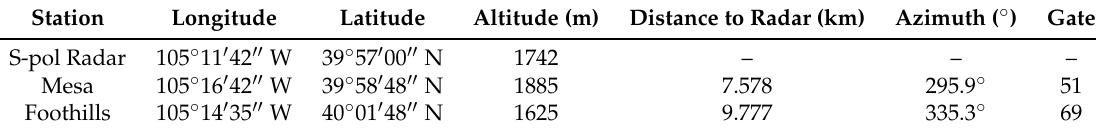
Table 2. Location parameters of the S-Pol Radar and the weather stations.